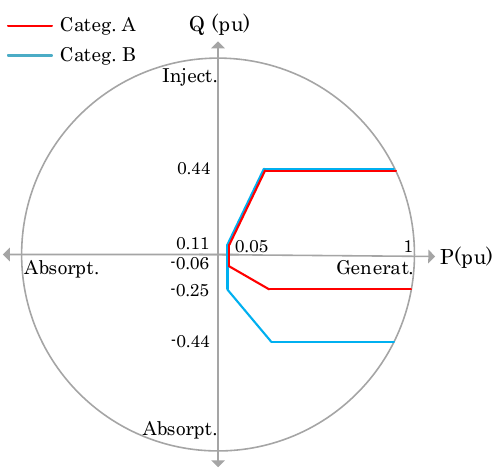
Figure 1. Power capability curves for DERs Category A and B, according to the IEEE